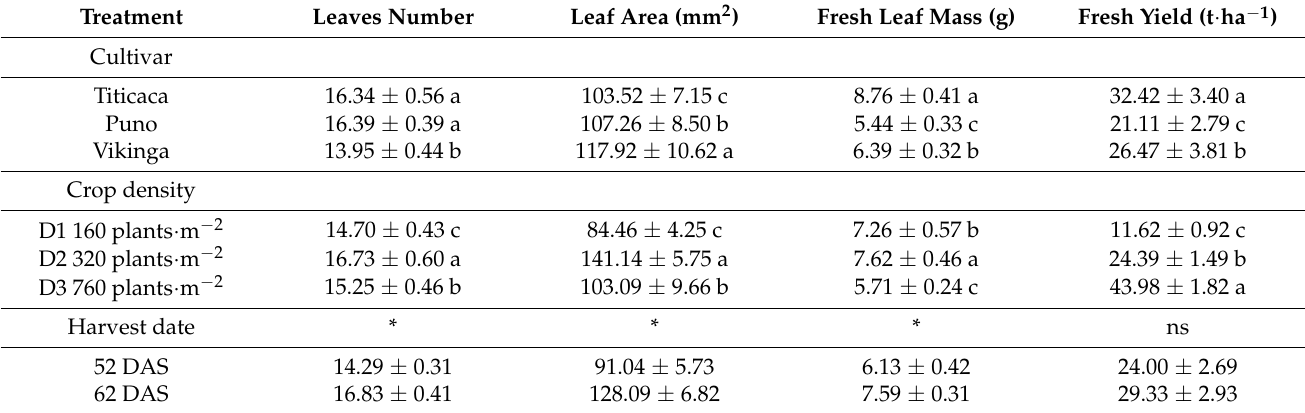
Table 3. Cultivar, plant density and harvesting time effect on quinoa leaf cultivars.